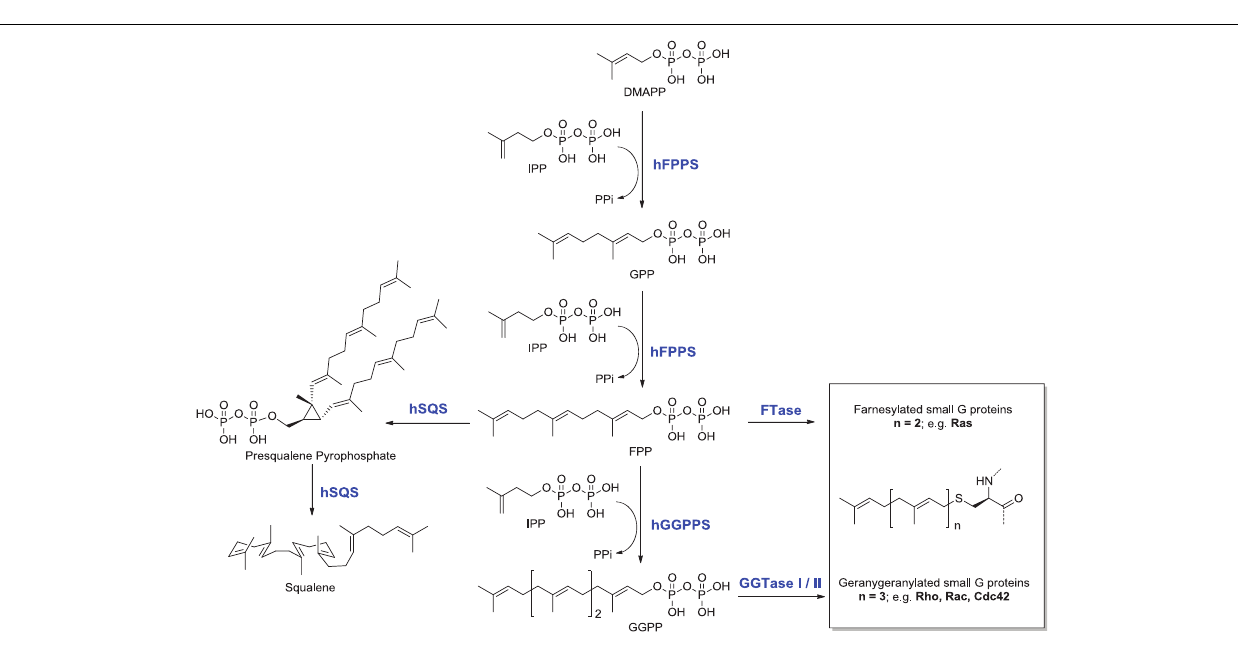
FIGURE 2 | Structures and sequence of steps involved in the biosynthesis of key isoprenoids.